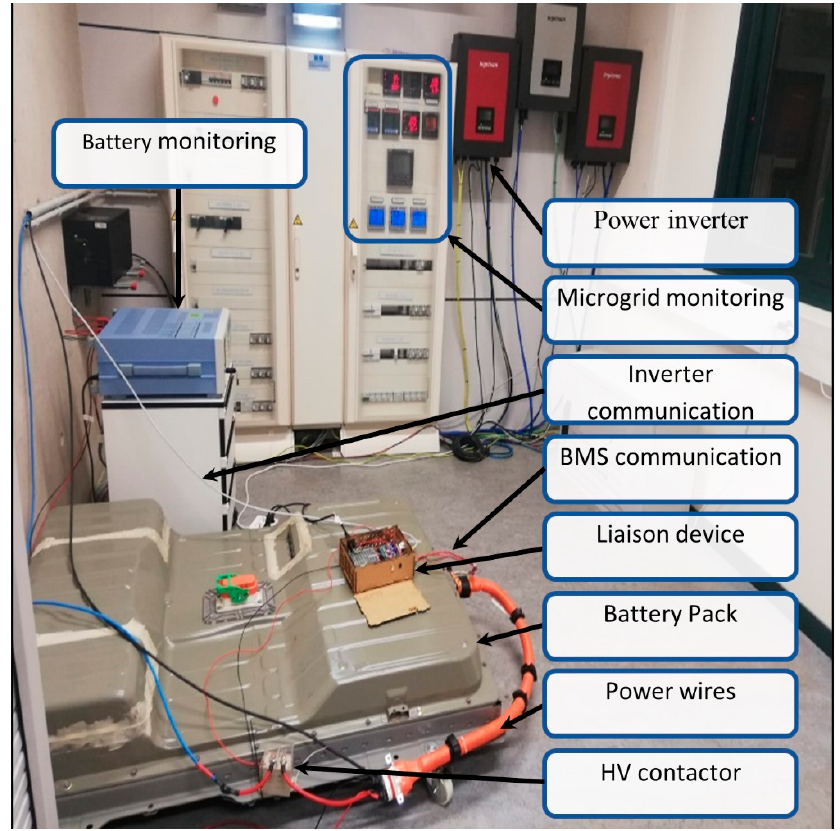
Figure 9. Liaison device connected to the Nissan ® EV First Generation Pack at the Laboratory for Energy Storage and Microgrids of the Public University of Navarre.